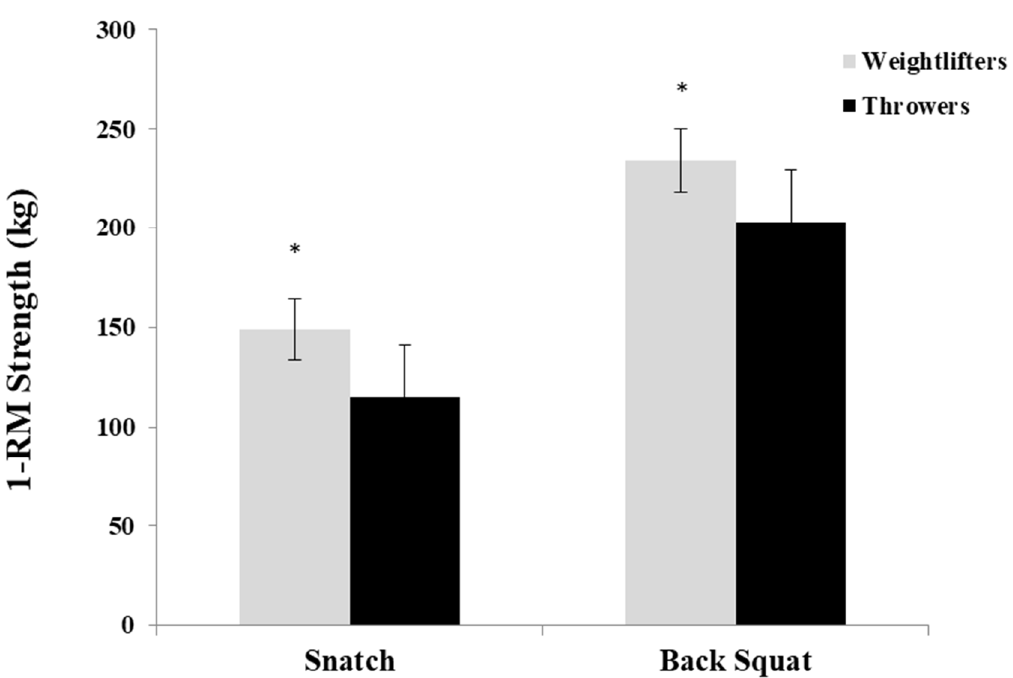
Figure 2. Performance in 1-RM strength in snatch and back squat (±SD). With (*) denoted the significant difference between weightlifters and throwers.